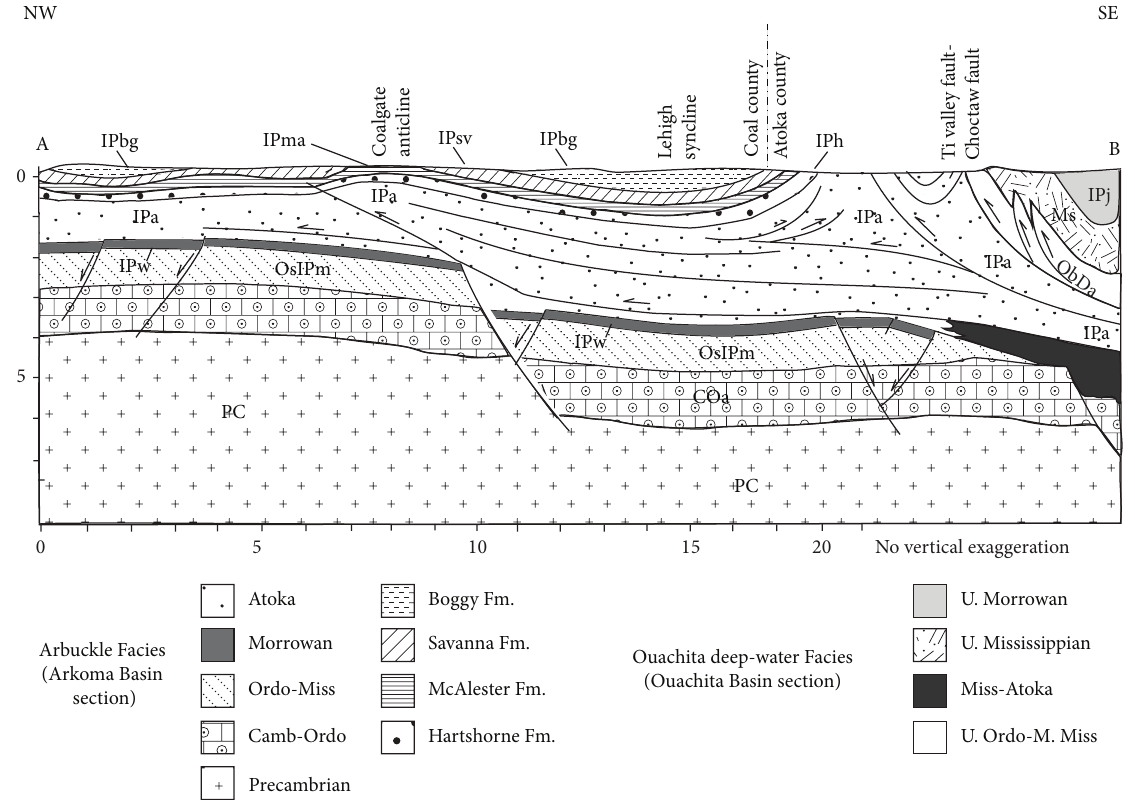
Figure 4: Structural cross section AB across Ouachita orogenic belt, modified from